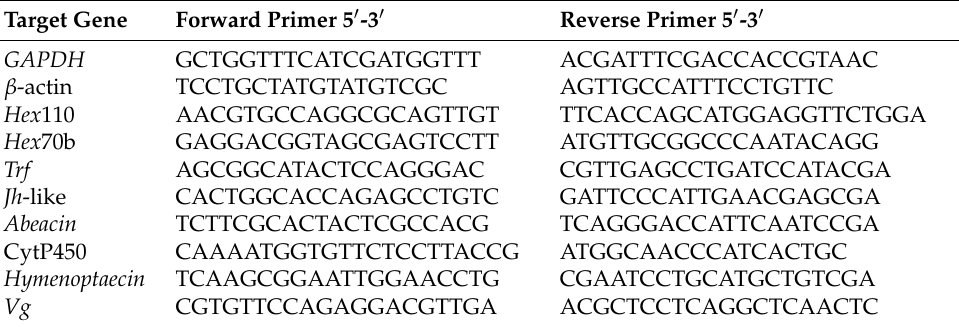
Table 1. Primers used in quantitative PCR and their